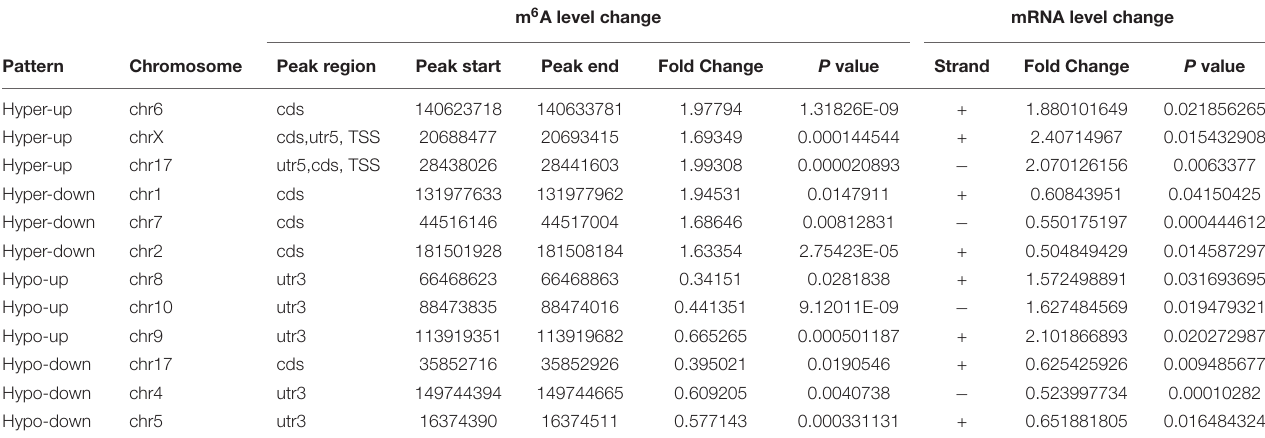
TABLE 2 | The ranking of the top 3 genes in each quadrant graph.